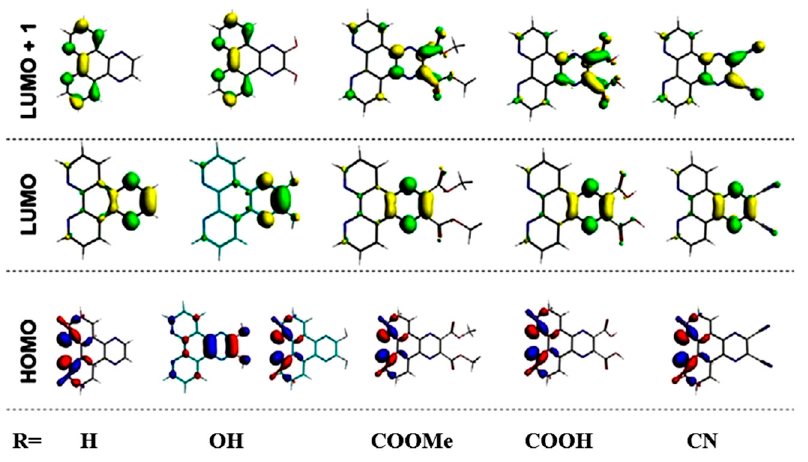
Figure 15. HOMO, LUMO and LUMO + 1 molecular orbitals of R2ppl. free ligands.